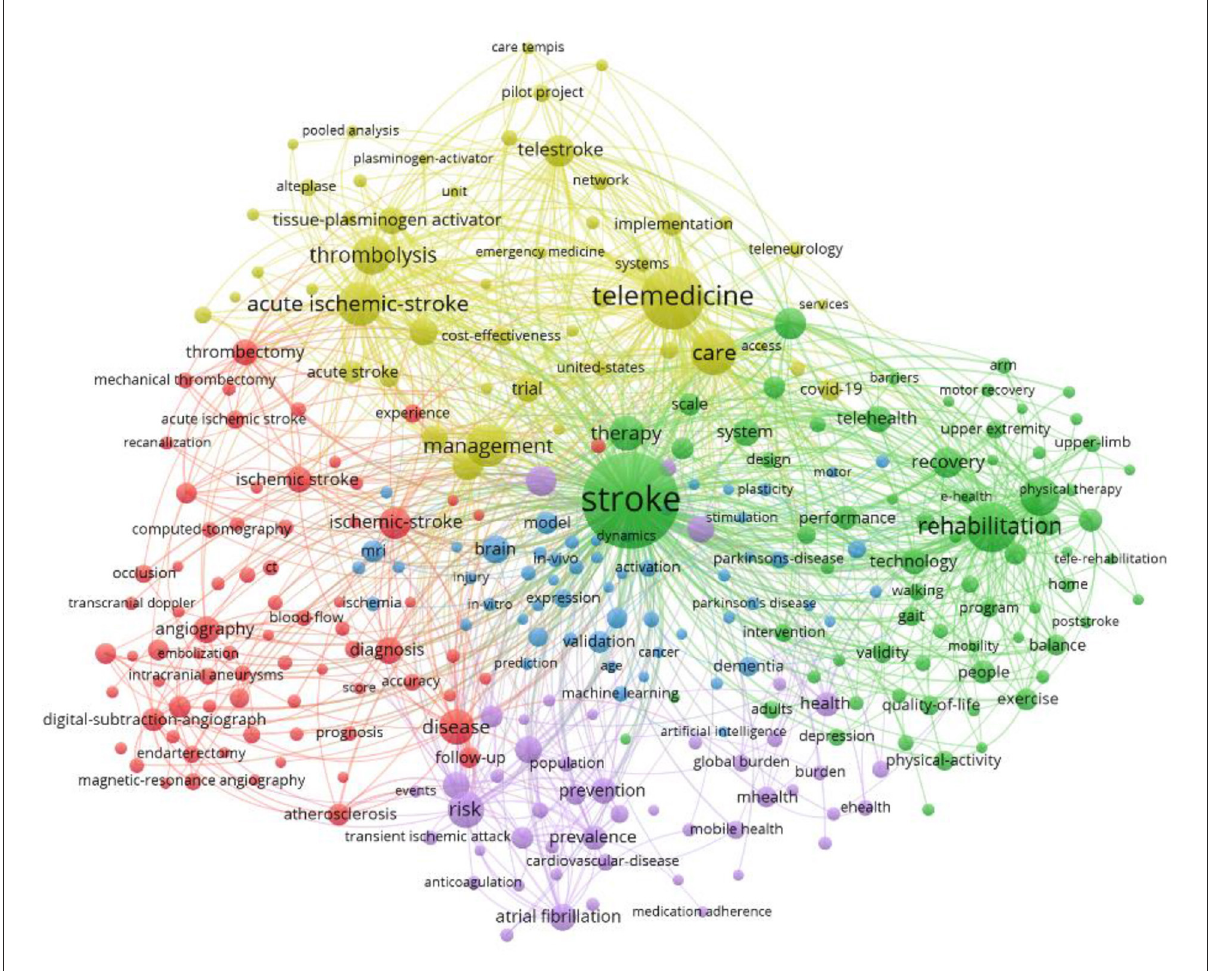
FIGURE4 The link strength map of keywords.